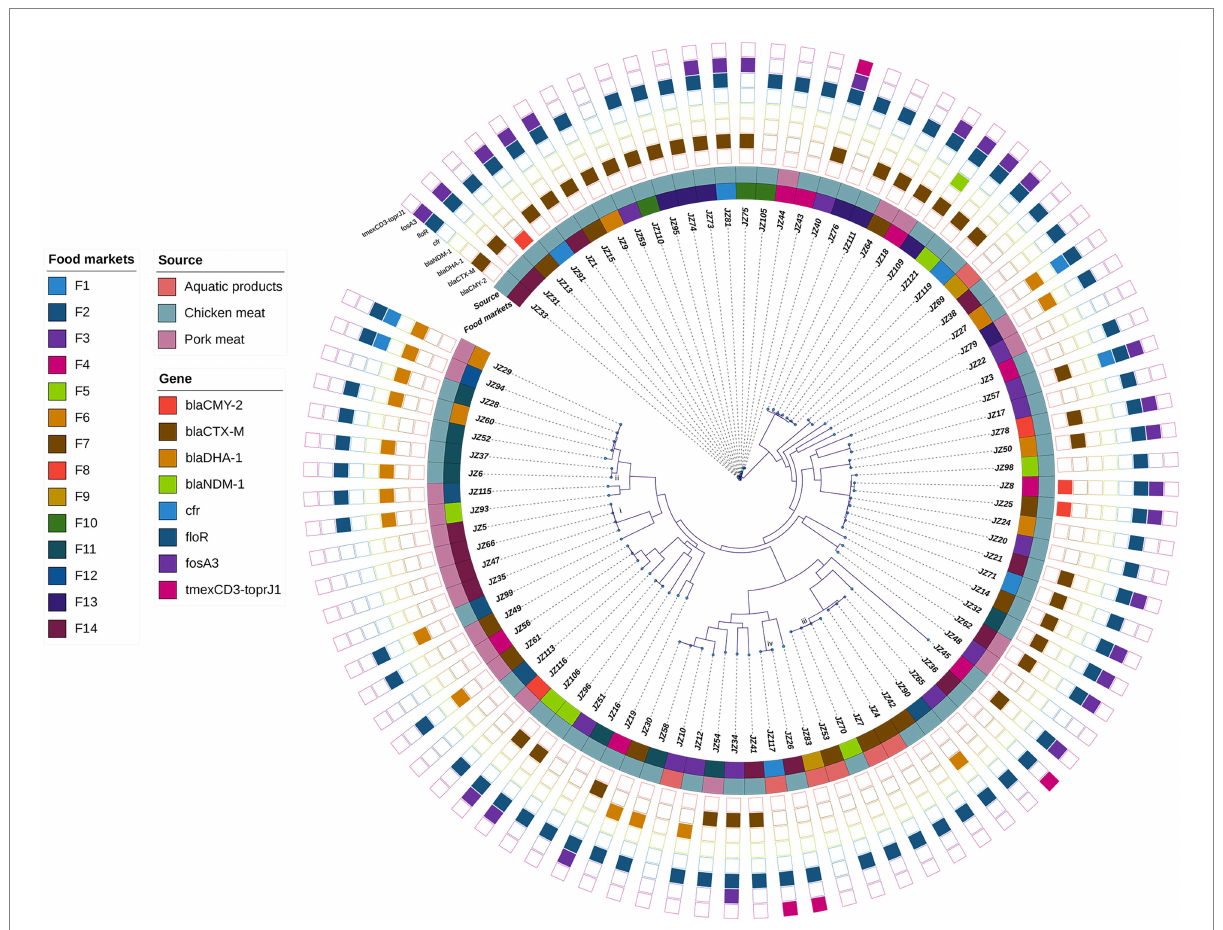
FIGURE 1 Phylogenetic analysis of 89 P. mirabilis strains. The food markets, sources and the presence of some clinically important antimicrobial resistance genes are indicated by different colours. i–iv represent four clonal transmission events (SNPs ≤ 5 among strains in the same